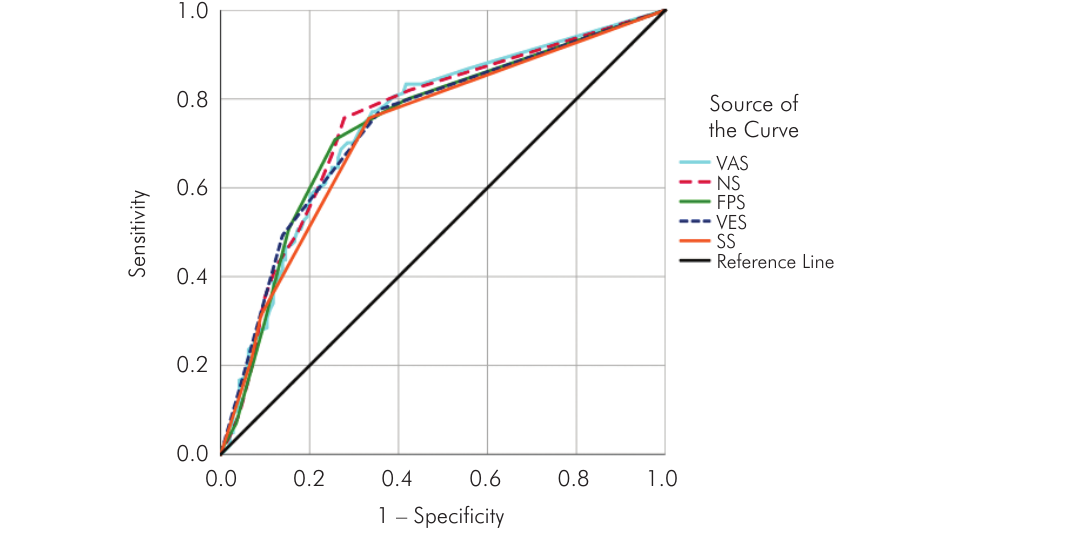
Figure 2. ROC curve analysis of the DH